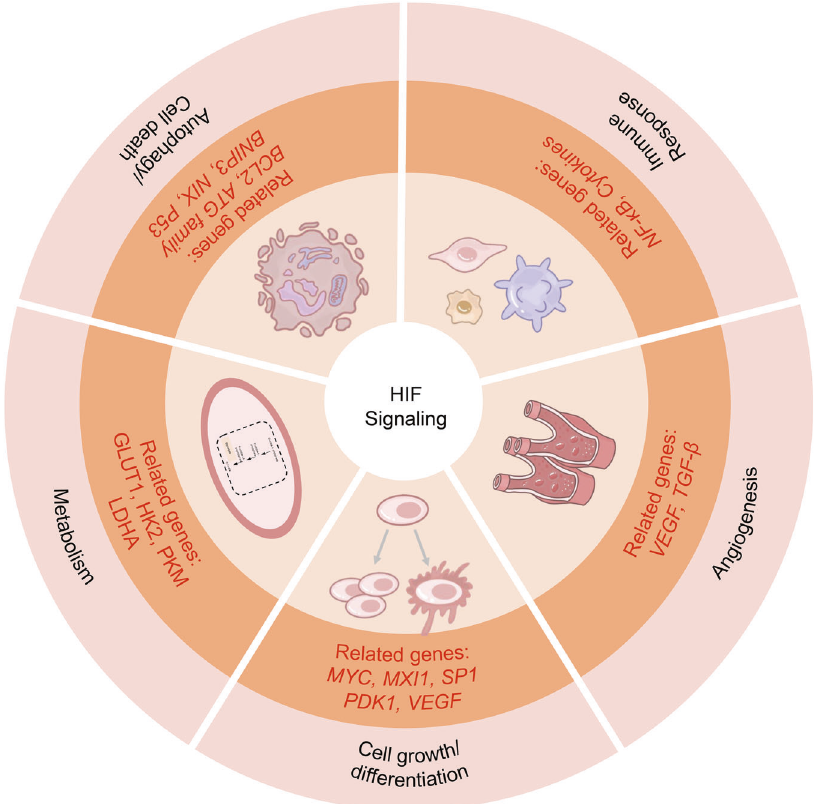
Fig. 3 Biological functions of hypoxia signaling. Hypoxia signaling companied with the related genes participates in multiple biological